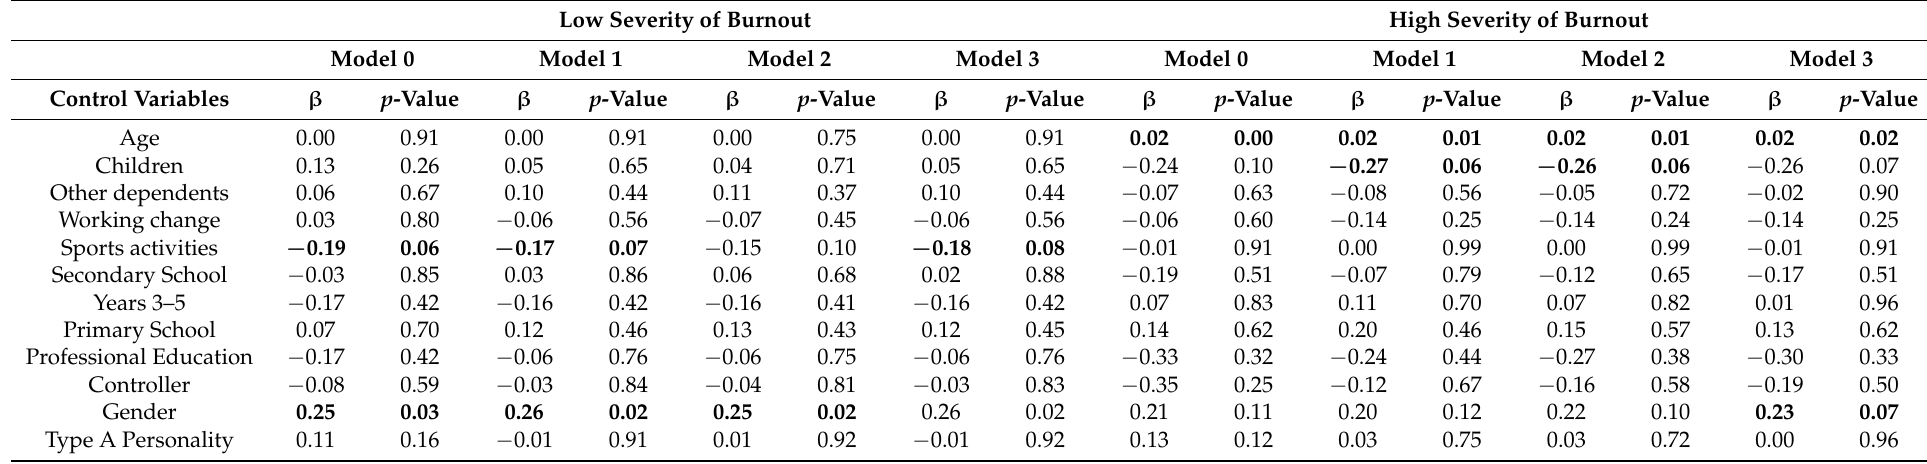
Figure 4. Summary of the significant relations found in the paper. *: multiplied by. Table 3. Regression models for the severity of stress in low burnout and high burnout